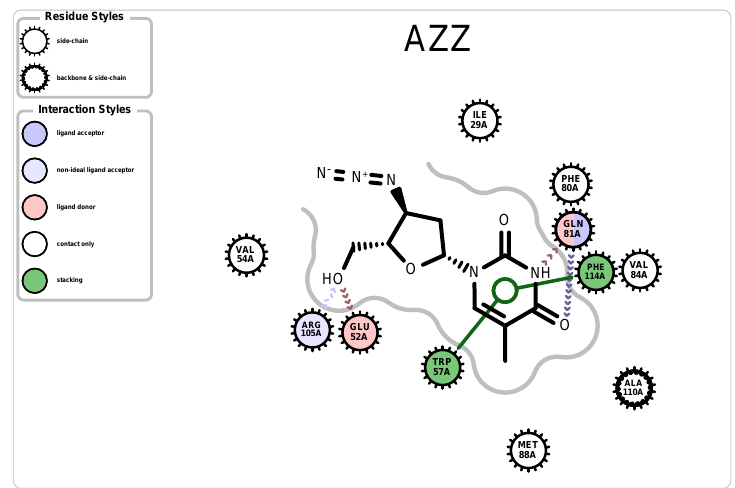
Figure 6. A protein-ligand interaction map generated from the third party software, OpenEye , visualizing the interaction between PDB 2JJ8 and ligand AZZ.